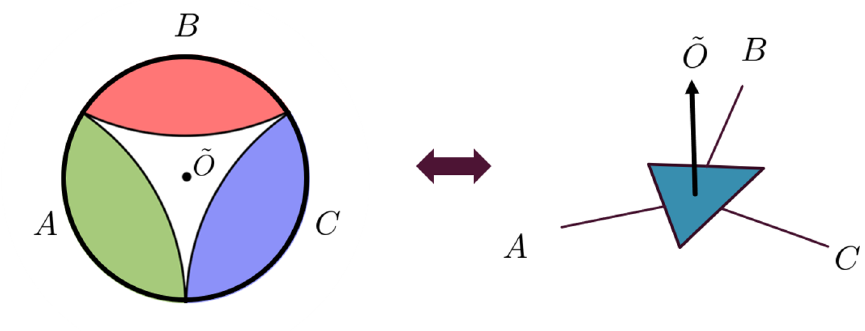
Figure 3. The left figure shows that the entanglement wedge of boundary subregions A, B, and C (coloured green, red and blue respectively) do not contain the central region where ˜ O resides. However, their respective complementary wedges (that of BC, AC, and AB) do contain the central region. Hence we can reconstruct the operator ˜ O on the union of any such two boundary subregions. This is similar to a qutrit code (right figure), where physical qutrits are represented as in-plane legs of the tensor network, and the logical qutrit is represented by a leg out of the